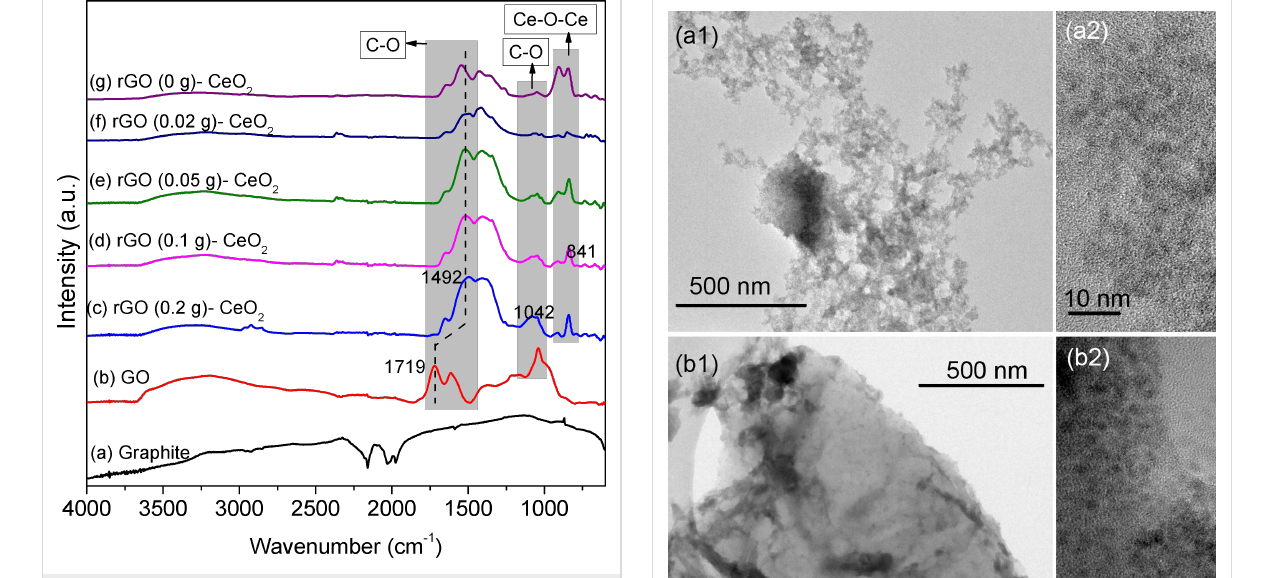
Figure 3: IR spectra of graphite (a); GO (b); CeO 2 with rGO-like organic residues (sample rGO(0)–CeO 2 ) (g); rGO–CeO 2 composites with different proportions of added rGO (c–f) after solvothermal treat- ment in ethanol. particle size of the undoped sample was 1.9 nm, and changed to 1.9–2.2 nm upon addition of 0.02–0.1 g GO. Only the sample